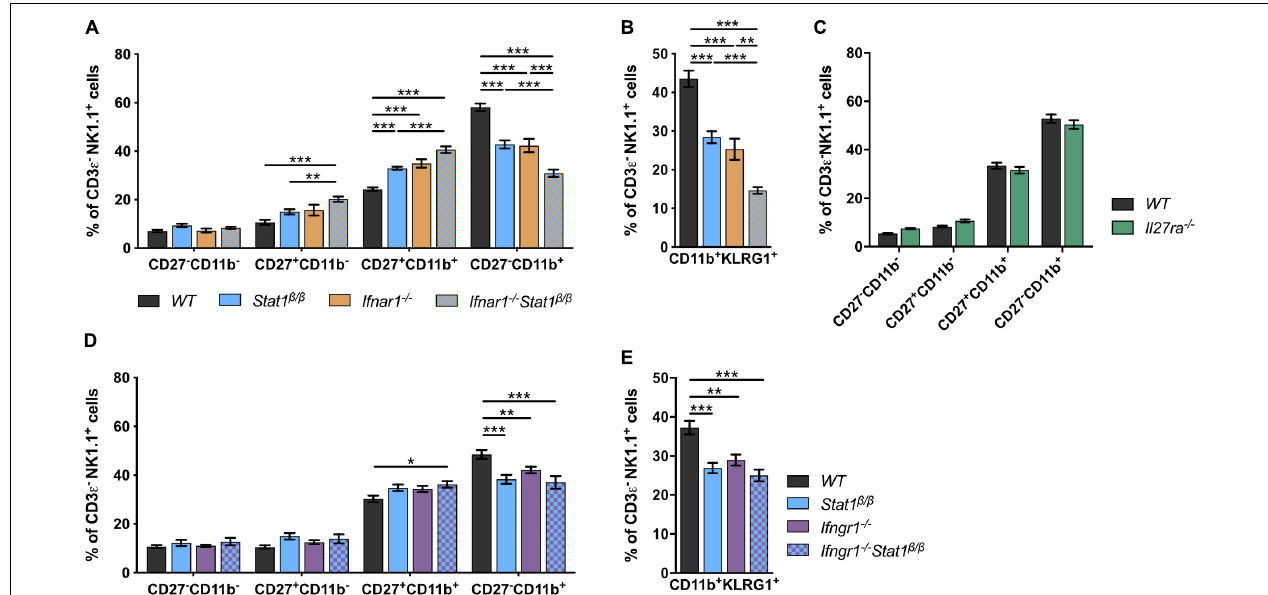
FIGURE 2 | The defective NK cell maturation in Stat1 β / β mice reflects impaired IFN γ , but not IFN α / β , signaling. (A–E) Splenic NK cells (CD3 ε − NK1.1 + ) from WT, Stat1 β / β , Ifnar1 − / − , and Ifnar1 − / − Stat1 β / β (A,B) , WT and Il27ra − / − (C) , WT, Stat1 β / β , Ifngr1 − / − , and Ifngr1 − / − Stat1 β / β (D,E) mice were analyzed for the maturation subsets CD27 − CD11b − , CD27 + CD11b − , CD27 + CD11b + , and CD27 − CD11b + (A,C,D) and CD11b + KLRG1 + (B,E) by flow cytometry. Mean percentages ± SEM from eight ( n = 5–18) (A,B) , two ( n = 12) (C) and six experiments ( n = 10–14) (D,E) are depicted. * p < 0.05; ** p < 0.01; *** p <